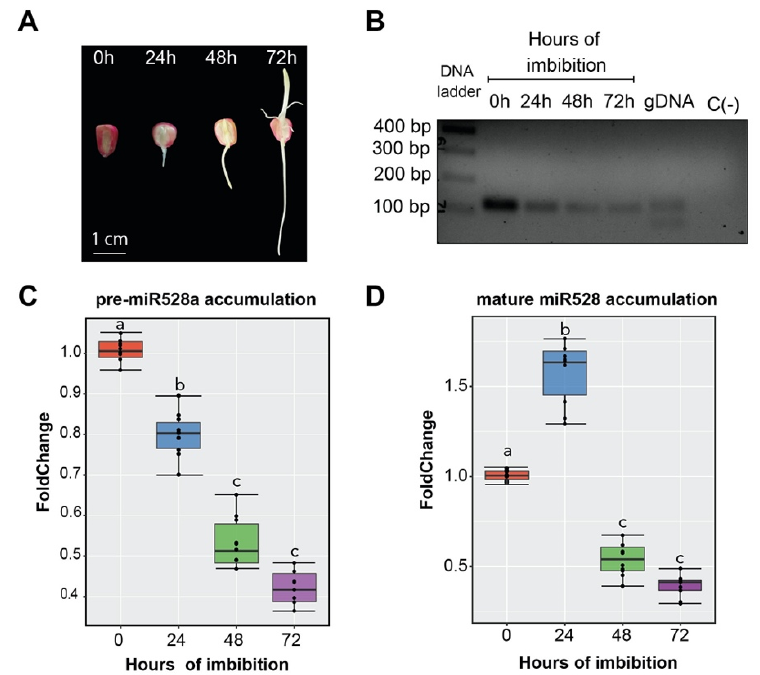
Figure 3. Accumulation levels of zma- MIR528a precursor upon seed germination. ( A ) Maize VS-535 seeds were germinated in vertical chambers, and seedling emergence was registered upon 0, 24, 48, and 72 h after imbibition. ( B ) Detection of pre-miR528a by end-point RT-PCR in samples collected at each timepoint. Oligonucleotides were designed to amplify both pre-miR528a (123 nt) and pre- miR528b (78 nt), as shown for genomic DNA (gDNA). ( C , D ) Quantification by real-time PCR of pre-miR528a and mature miR528 in maize embryonic axes at the indicated stages of seed imbibition. Fold change represents the abundance relative to dry seed (0 h) normalized either by 18S rRNA (precursor) or U6 snRNA internal control (mature miRNA). Error bars represent the standard error of the mean from three biological replicates with three technical replicates for each one ( n = 9). Data were analyzed by one-way ANOVA with multiple comparisons by the Tukey post hoc test. Boxes that do not share at least one identical letter differ significantly ( p < 0.05) from each other.